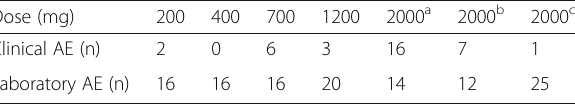
Table 4 Number of adverse events (AE) in relation to dose administered ( n =